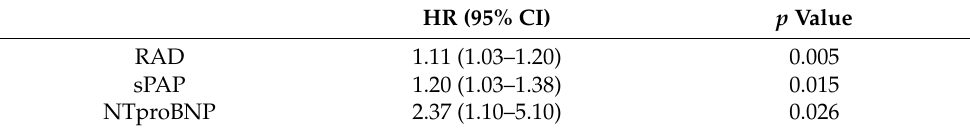
Table 4. Independent predictors of severe AF-TR.